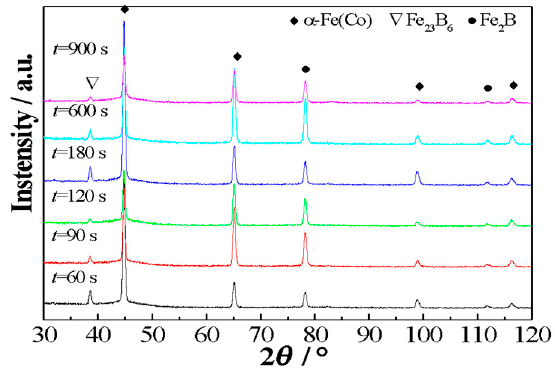
Figure 2. XRD patterns of the (Fe 0.4 Co 0.6 ) 79 Nb 3 B 18 alloys annealed at 764 K for varied times.